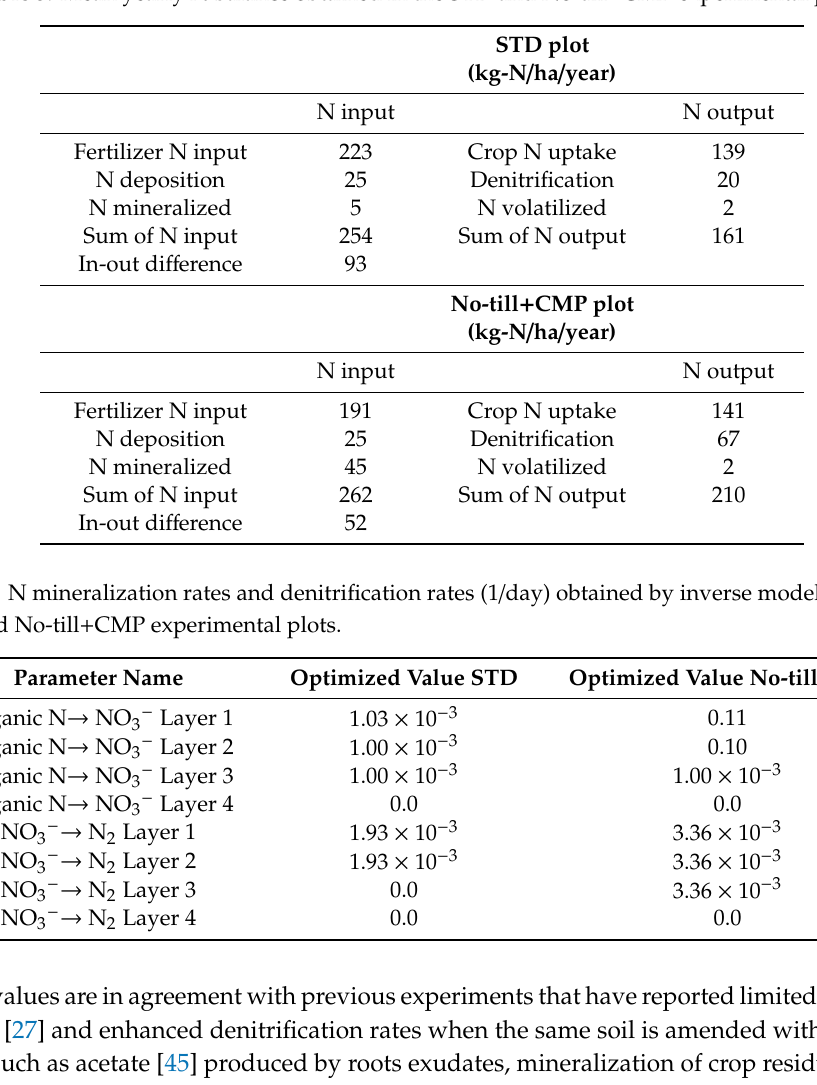
Table 5. Mean yearly N balance obtained in the STD and No-till + CMP experimental plots.